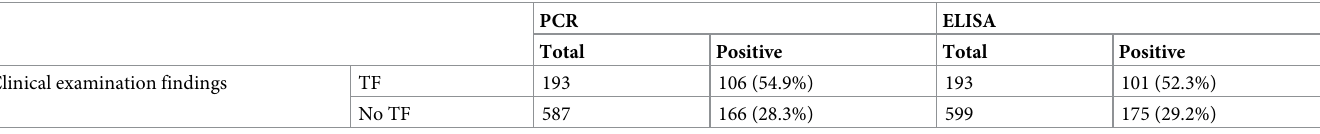
Table 2. Comparison of detection of ocular Chlamydia trachomatis by polymerase chain reaction and anti-Pgp3 antibodies by enzyme-linked immunosorbent assay in 1–9-year-old children with and without trachomatous inflammation—follicular in either eye, Nauru, July